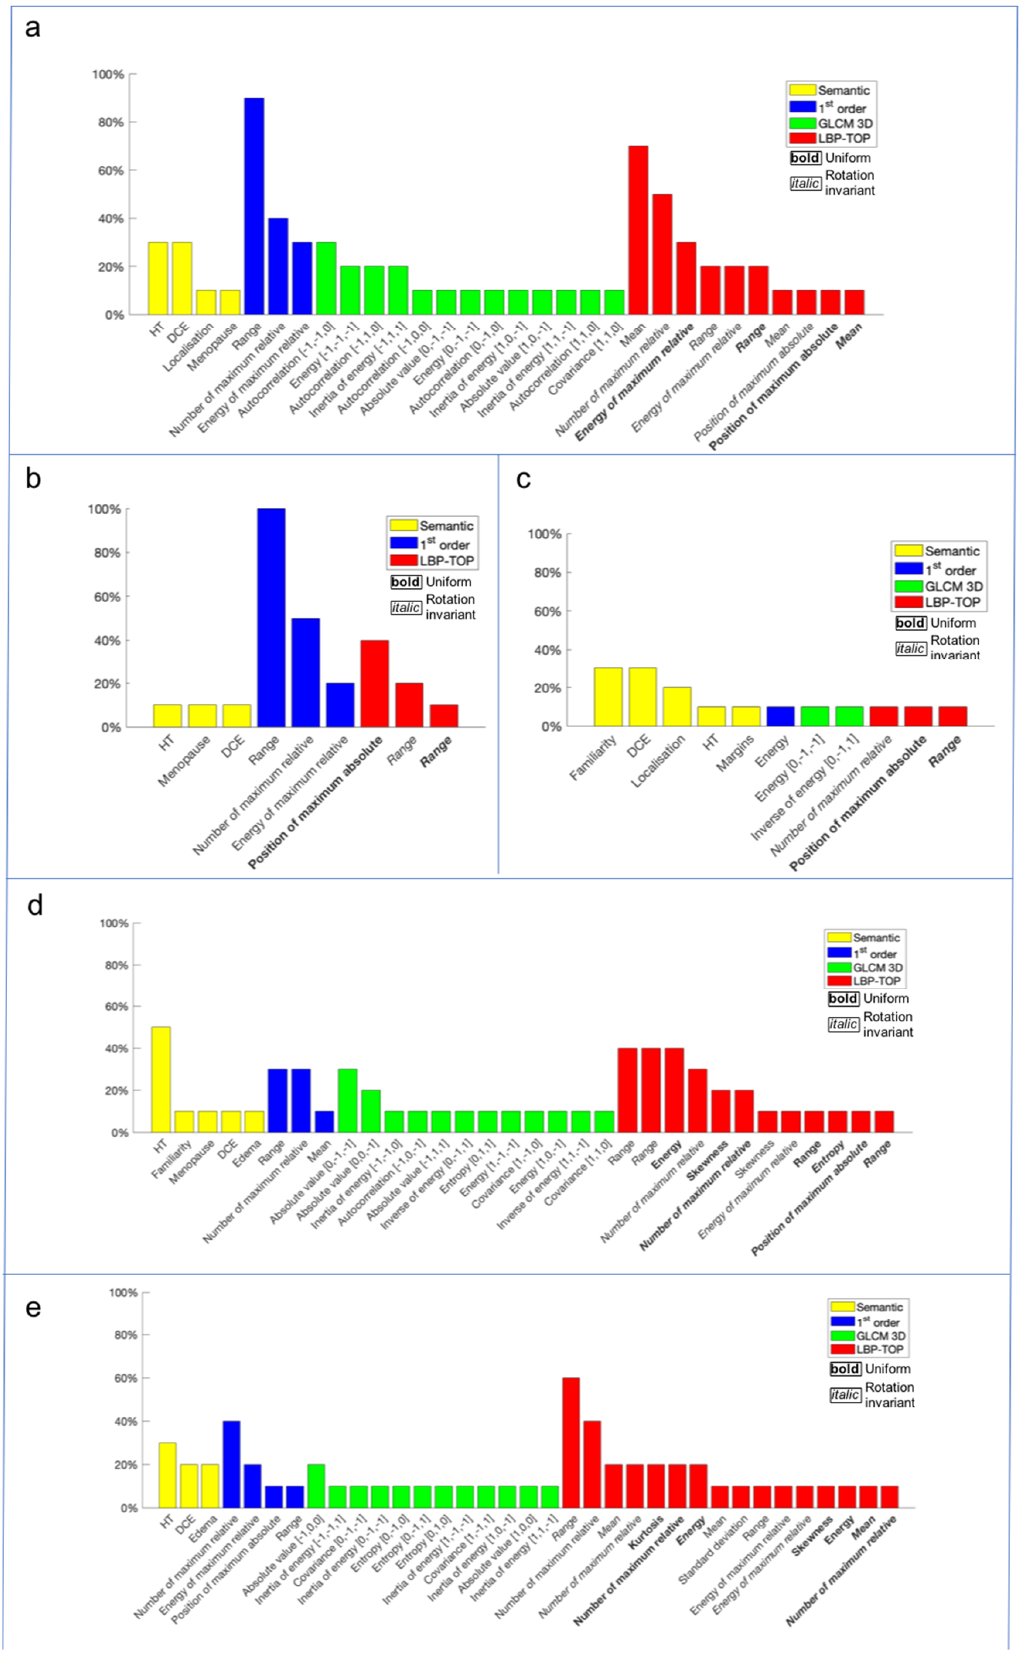
Figure 3. The charts show the most significant features, selected by a wrapper filter, for each histological label: ( a )